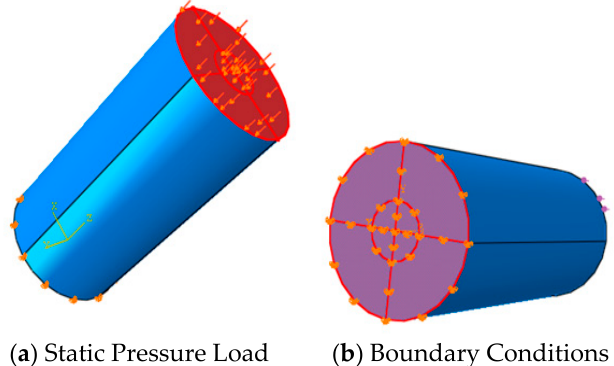
Figure 5. Load and boundary conditions of FRP strengthened column model. ( a ) Mesh of concrete by size; ( b ) Mesh of FRP by size.